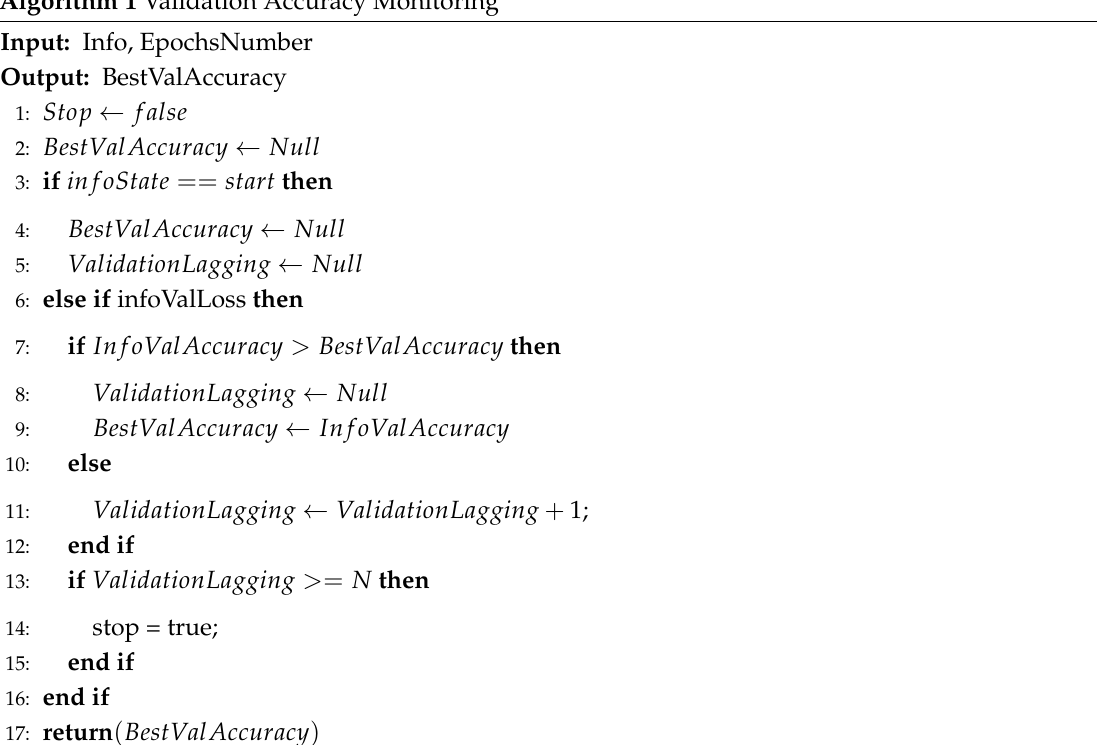
Algorithm 1 Validation Accuracy